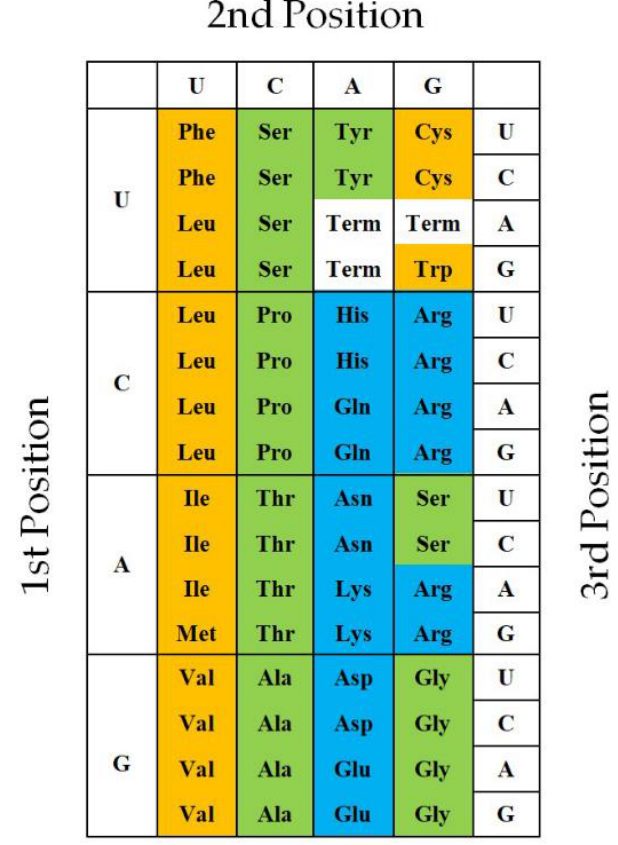
Figure 7. Twenty natural amino acids are characteristically arranged in the universal genetic code table at every three base positions of codon. Amino acids in brown, green and blue boxes mean hydrophobic, intermediate and hydrophilic amino acids.